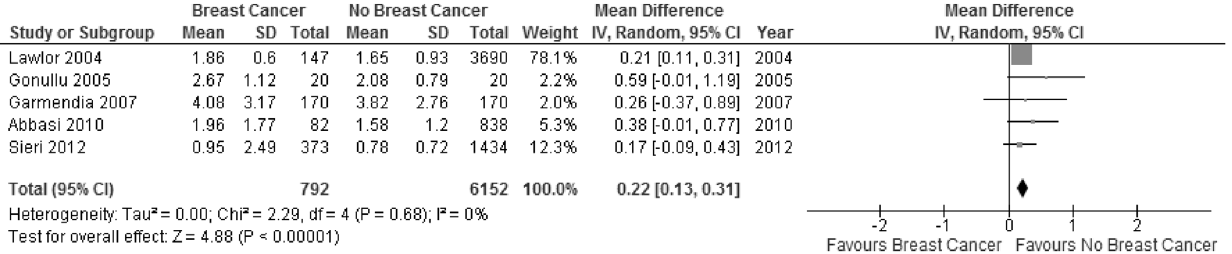
PLOS ONE | www.plosone.org